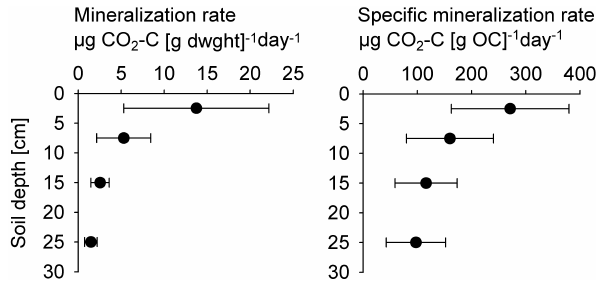
Fig. 9. Average C mineralization in the mineral soil over 20days across all sites, given per gsoil dry weight and per gOC ( ± standard deviation).